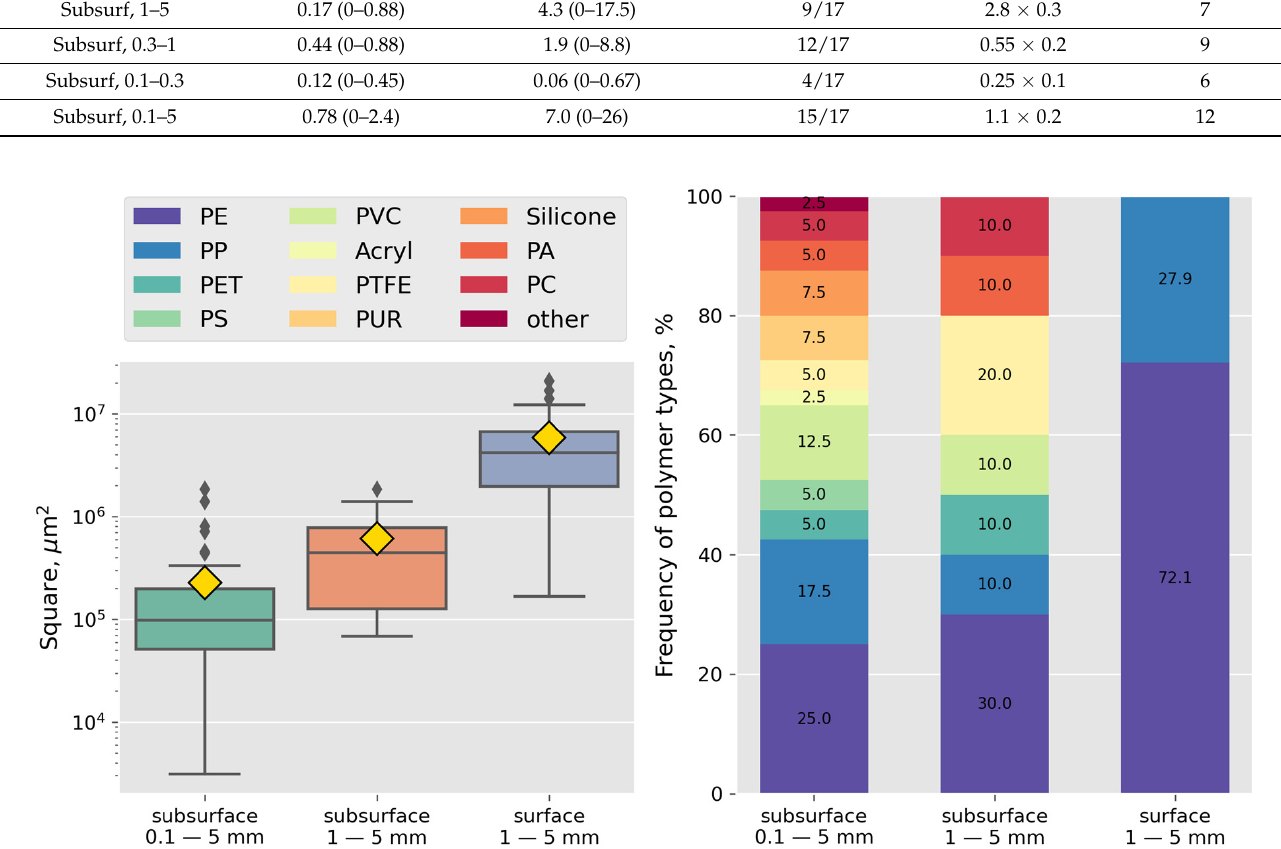
Figure 3. Surface square ( left ) and polymer composition ( right ) of found microplastics (“square” refers to the surface area of a particle).